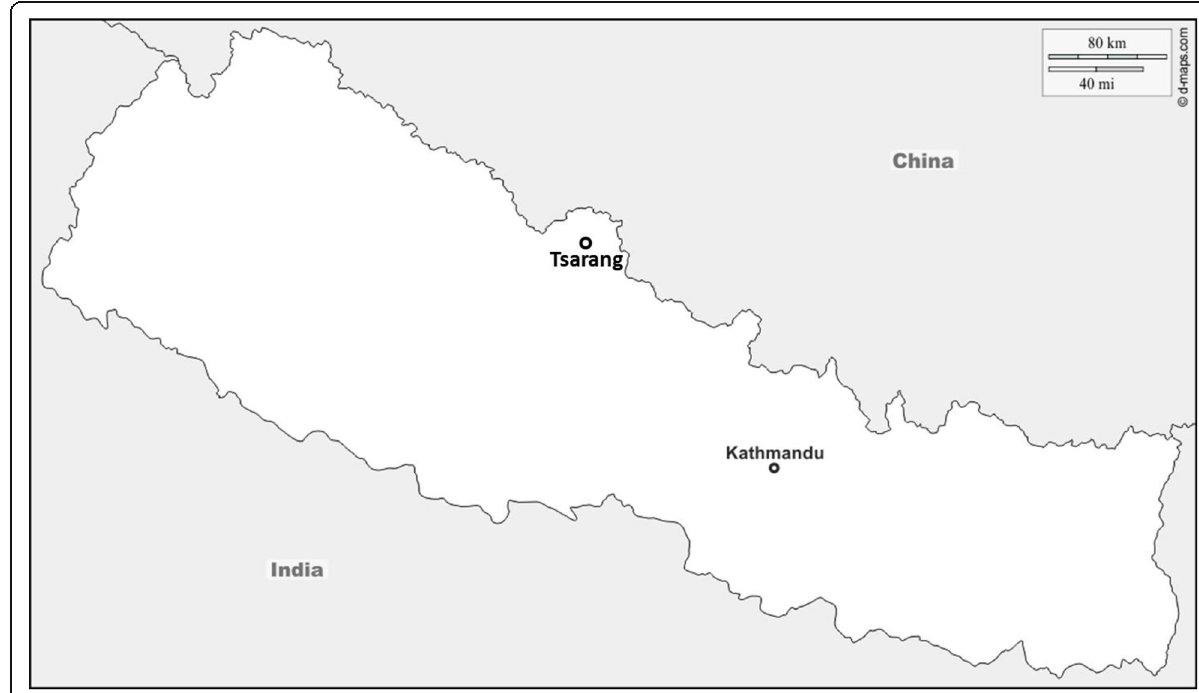
Fig. 1 Location of Tsarang village. Tsarang is located in Mustang district in northern Nepal and is at an altitude of 3560